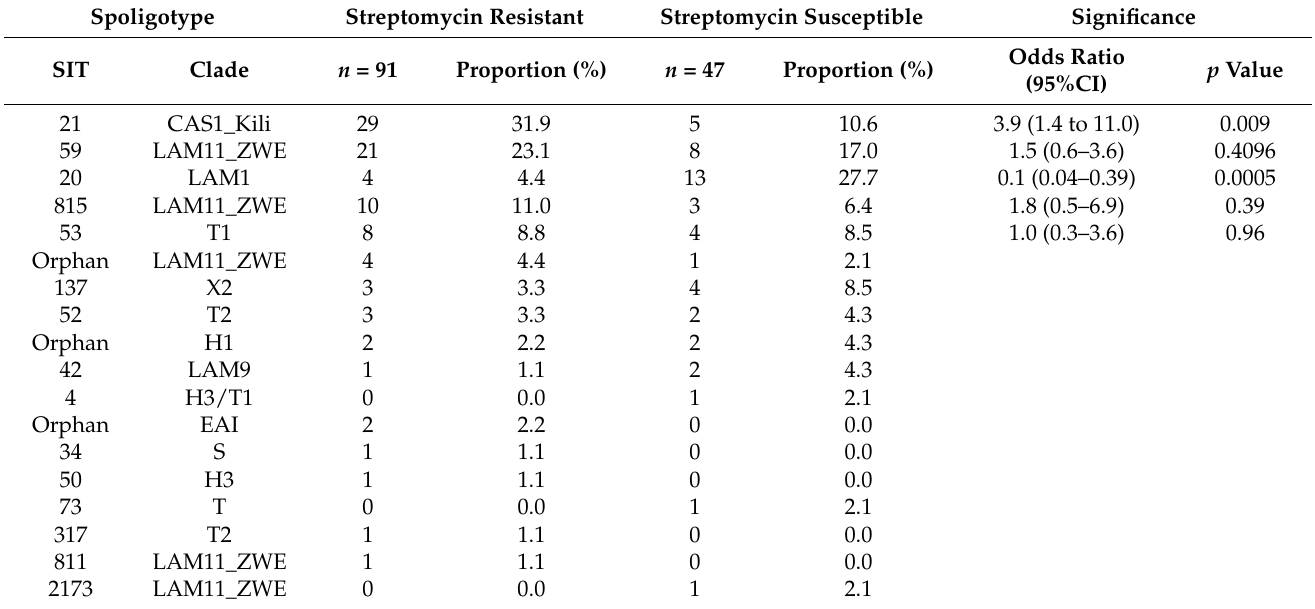
Table 1. Correlation between genotypes and phenotypic STR susceptibility.